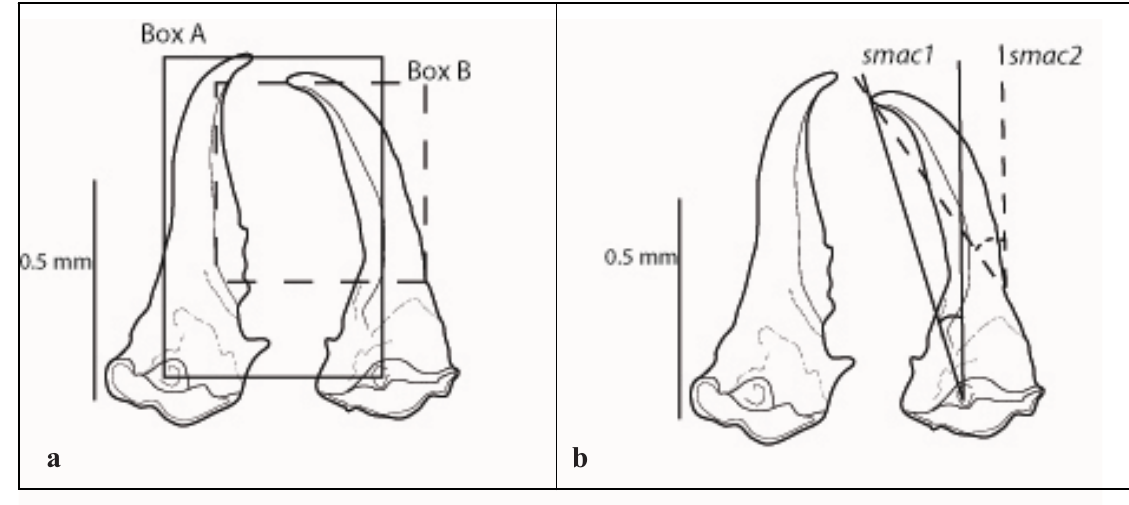
to determine the 90° for measurement, ( b ) angles measured for smac1 (Box A) and smac2 (Box B). Scale bar = 0.5